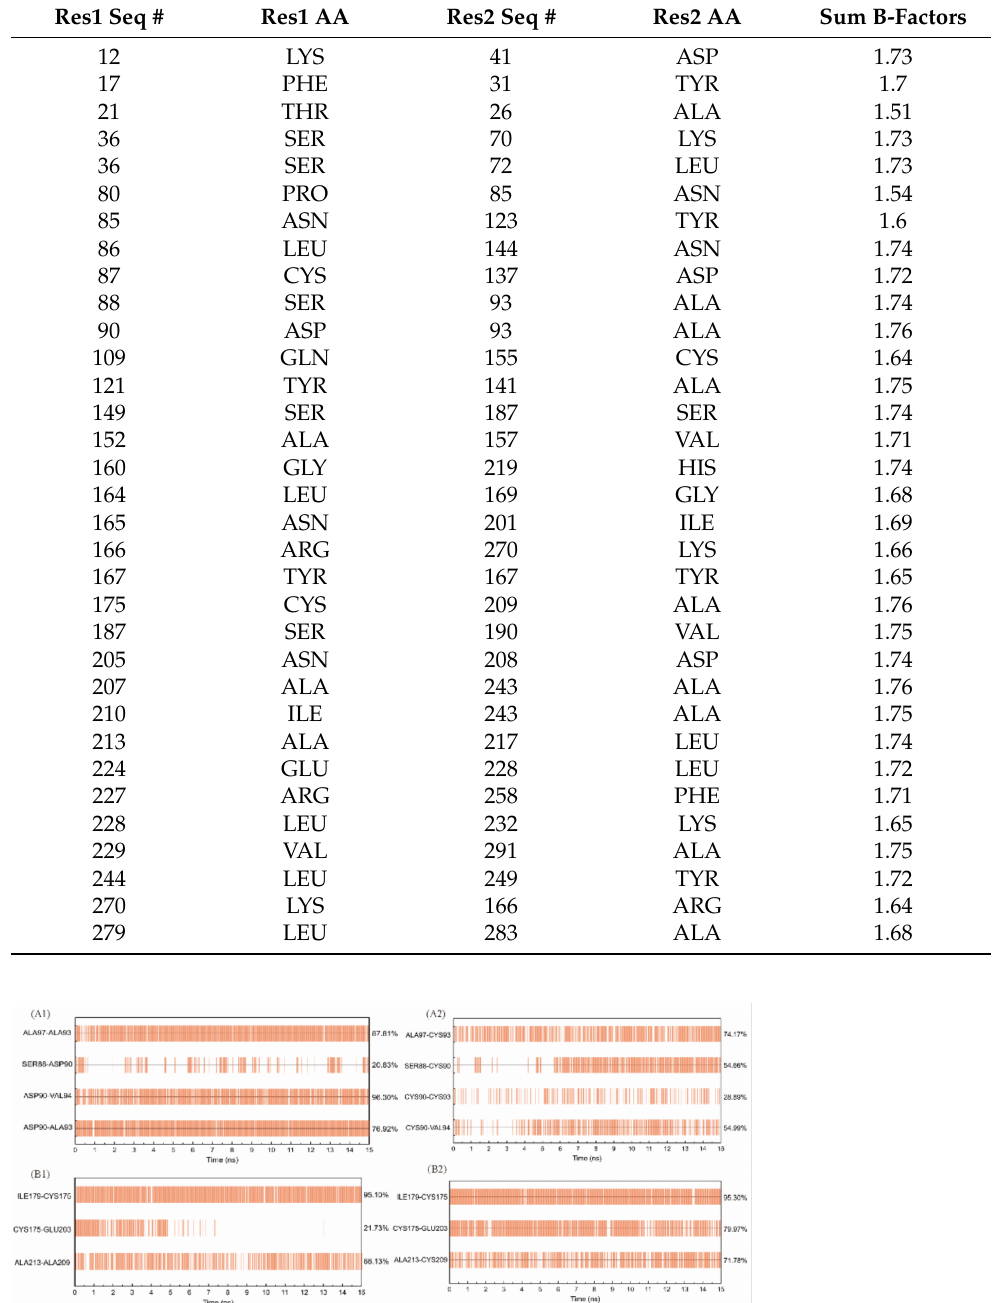
Table A2. Candidate mutational residue pairs.